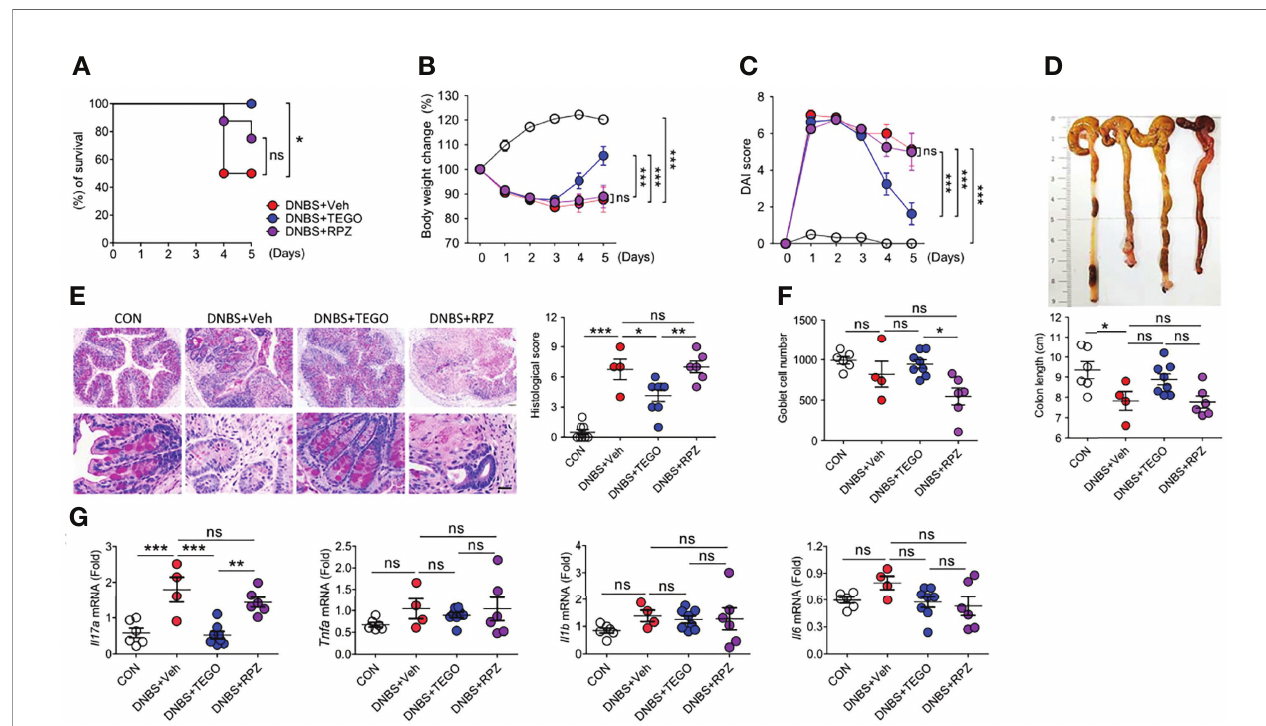
FIGURE 1 | Tegoprazan alleviates DNBS-induced colitis. Colitis was induced in 8-week-old male mice by rectally administering DNBS (5 mg in 100 µL of 50% ethanol). The mice were allocated to four groups: CON (n = 6), DNBS+Veh, DNBS+TEGO, and DNBS+RPZ (each n = 8). Tegoprazan (30 mg/kg) and rabeprazole (30 mg/kg) were administered orally twice daily throughout the experiment. All drugs were dissolved in 0.5% (w/v) methylcellulose. After sacri fi cing animals on Day 5, the entire colon from anesthetized mice was harvested for further investigations. The detailed methods are described in the Materials and Methods section. (A) Survival rate from survival model. Survival analyses were performed using Kaplan-Meier plots for overall survival and differences were compared using a log-rank test. (B) Body weight change. (C) Disease activity index (DAI). (D) Representative images of colons and analysis of colon length. (E) Representative images following periodic acid- Schiff (PAS)-staining and histological score. Scale bars = 20 m m. (F) Goblet cell number. (G) Gene expression levels of proin fl ammatory cytokines ( Il17 , Tnfa , Il1b , and Il6 ). Data represent the mean of triplicate real-time quantitative RT-PCR. For (D – G) , CON (n = 6), DNBS+Veh (n = 4), DNBS+TEGO, and DNBS+RPZ (each n = 6). Data represent the mean ± standard error of the mean (S.E.M). Signi fi cance is indicated by * p < 0.05, ** p < 0.01, and *** p < 0.001 using two-way ANOVA followed by Bonferroni post hoc test (B, C) or one-way ANOVA followed by Dunnett ’ s multiple comparison test (D – G) . ns, not signi fi cant; CON, treated with ethanol; DNBS, dinitrobenzene sulfonic acid; Veh, treated with vehicle; TEGO, treated with tegoprazan; RPZ, treated with